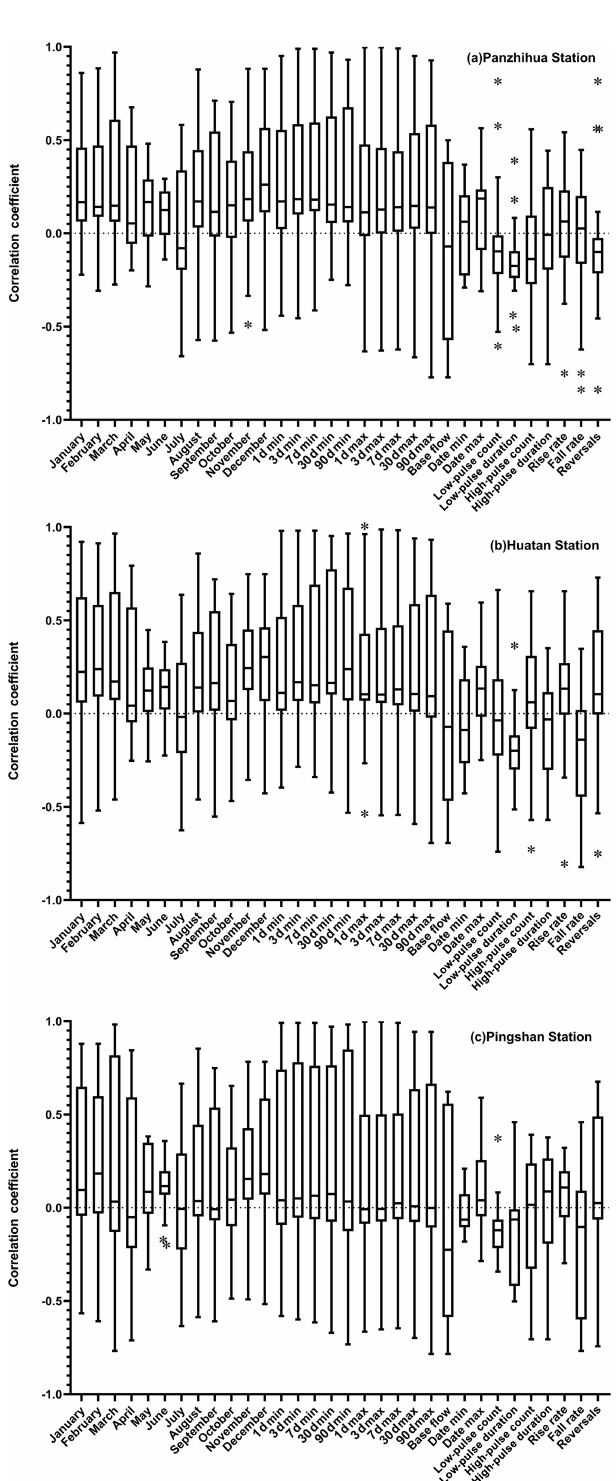
Figure 5. Correlation coefficients among the IHA statistics for the observed data sets in (a) Panzhihua Station, (b) Huatan Station and (c) Pingshan Station ( ∗ means